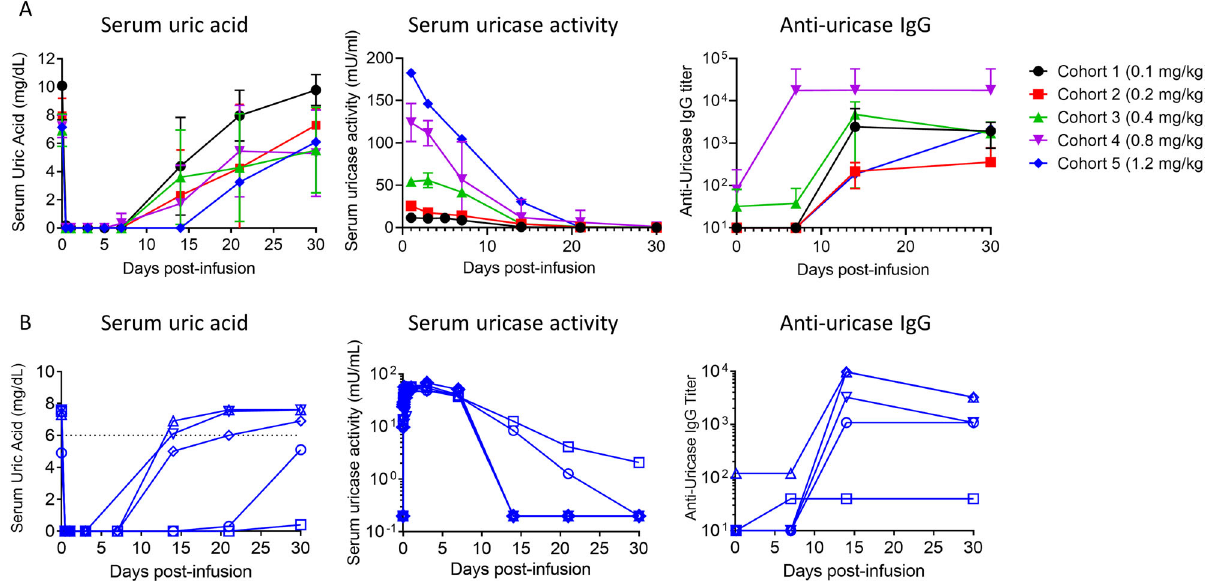
Fig. 2 Single ascending dose study of pegadricase in patients with hyperuricemia. A Patients with sUA > 6 mg/dL at screening were assigned to one of fi ve cohorts receiving a single IV infusion of pegadricase (0.1, 0.2, 0.4, 0.8 or 1.2 mg/kg). Each cohort consisted of 5 patients, except for cohort 5 (1.2 mg/ kg) which enrolled 2 patients. Blood was drawn at various timepoints indicated and sUA levels were determined. Lines represent the mean for each cohort and error bars represent the standard deviation. Only the mean is depicted for cohort 5. B Serum uric acid, serum pegadricase activity, and anti-uricase IgG antibodies are shown for the fi ve individual patients in cohort 3 (0.4 mg/kg pegadricase). One patient (square symbols) developed only low anti-uricase IgG titers and showed prolonged reduction of sUA and sustained serum pegadricase activity. Source data are provided as a Source Data fi le.